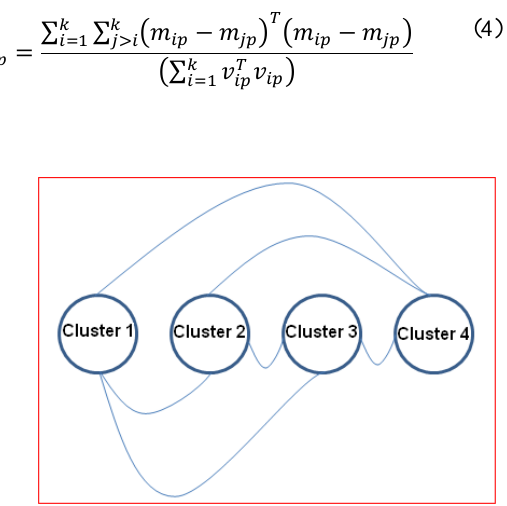
Figure 10. Graphical representation of ratio’s